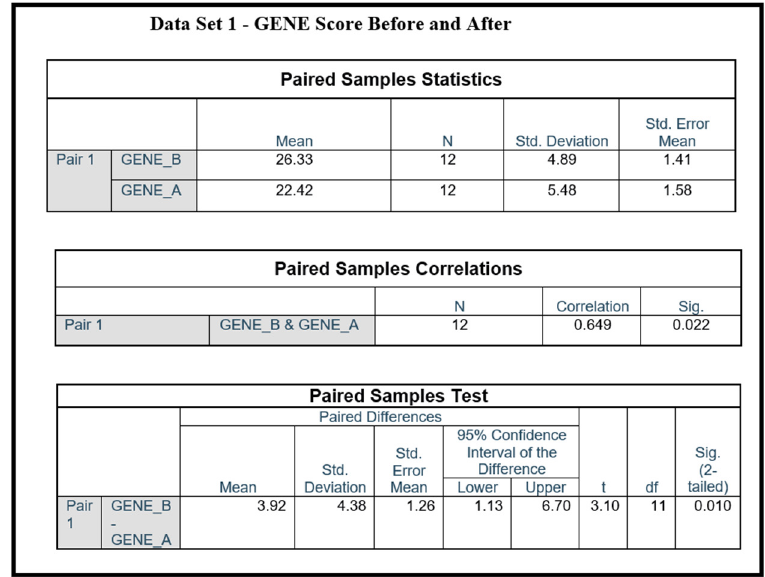
Figure 1. The null hypothesis for equal scores is rejected.